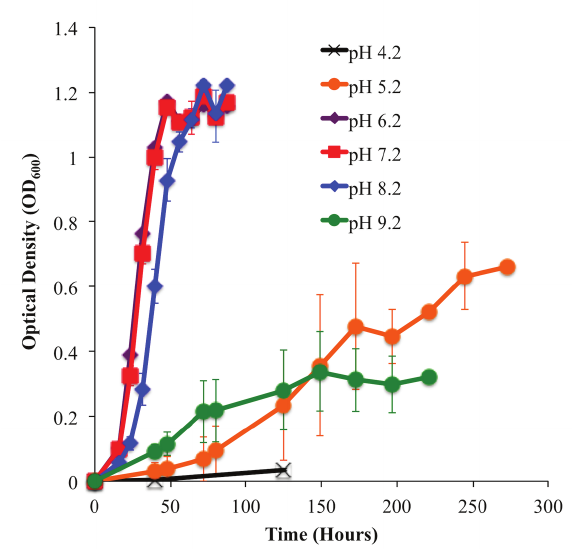
Figure 2. Growth Curve of Hvo cultures grown under acidic and alkaline conditions. Growth of Haloferax volcanii at pH 4.5 (black asterisks), pH 5.5 (black ×s), pH 6.0 (light green circles), pH 6.5 (light blue diamonds), pH 7.5 (red squares), pH 8.0 (blue diamonds), and pH 8.5 (green circles). Values for the symbols are the average of all replicates and the error bars represent the standard deviation at each time point.